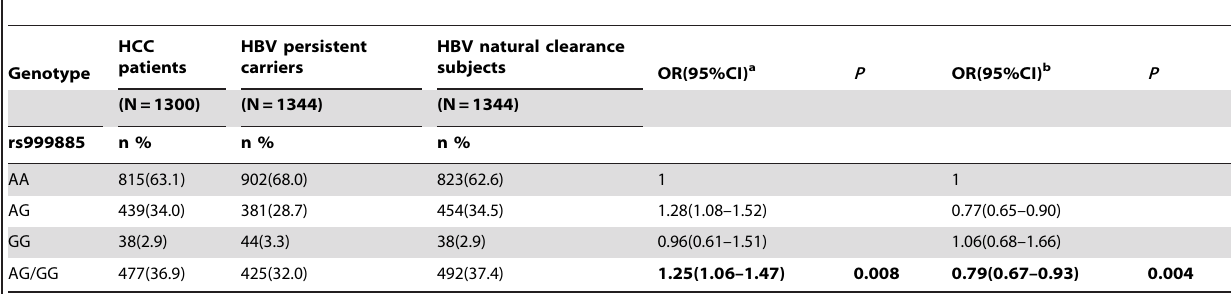
Table 1. Genotype frequencies of rs999885 and susceptibility of HCC and HBV persistent infection.